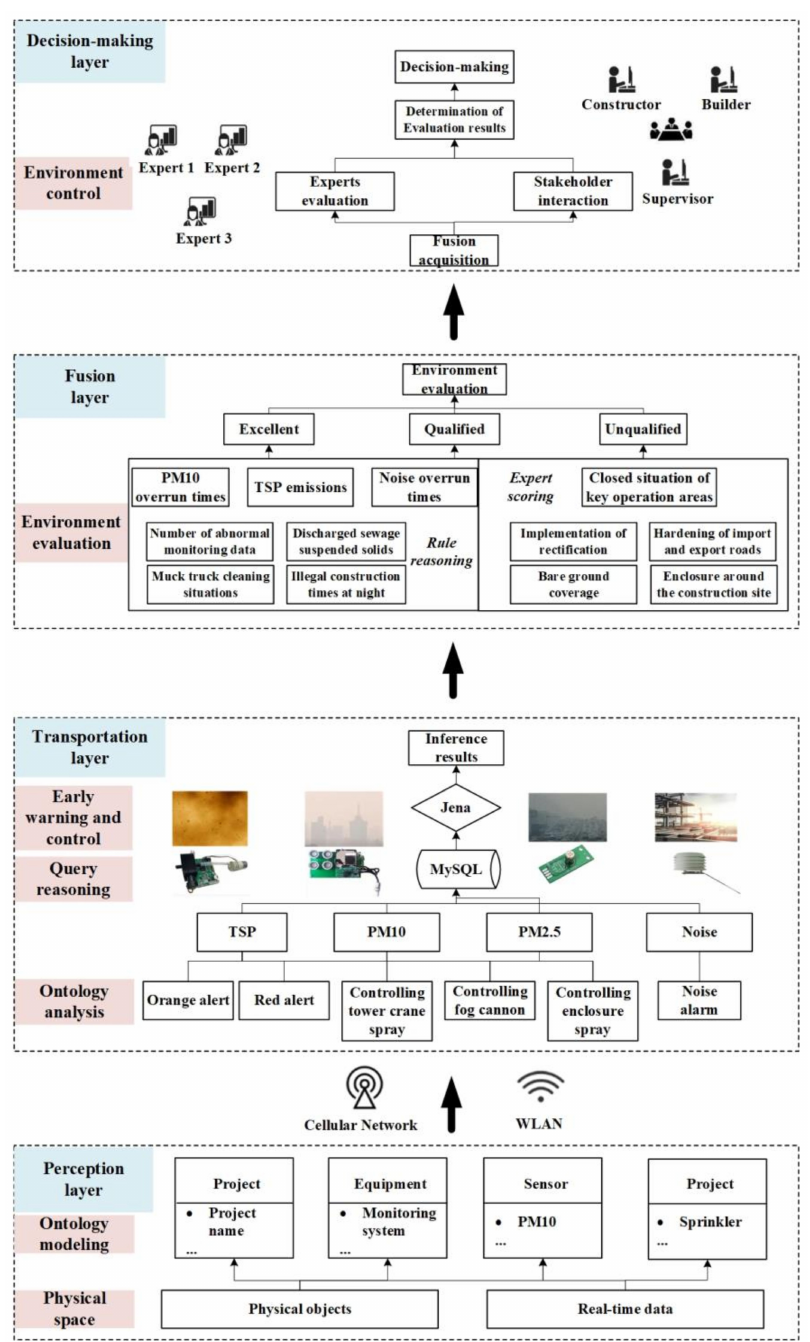
Figure 2. The ontology-based environmental monitoring and evaluation